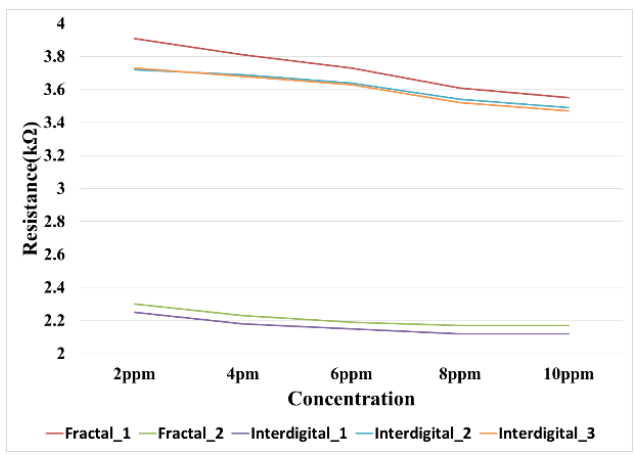
Figure 10. Resistance versus concentration curves of the five sensors.